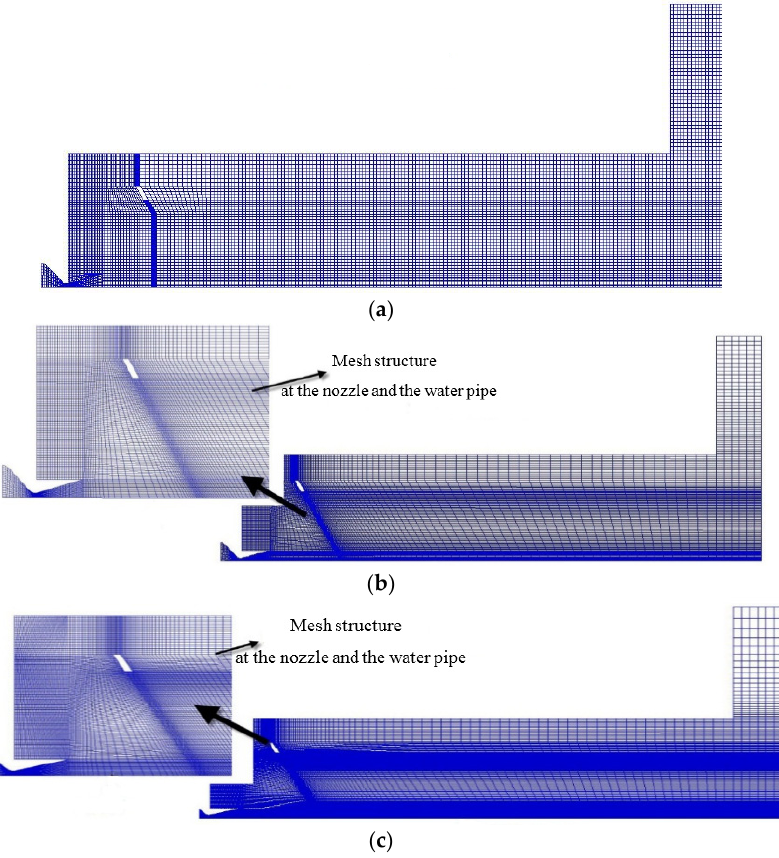
Figure 2. Mesh structure at the symmetry plane of the missile model. ( a ) Model A; ( b ) Model B; ( c ) Model C.